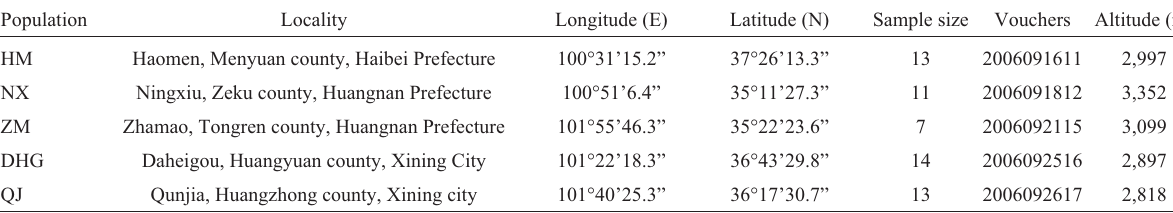
Table 1 - Sample information for the five cultivated populations of R. tanguticum used in this study. Population